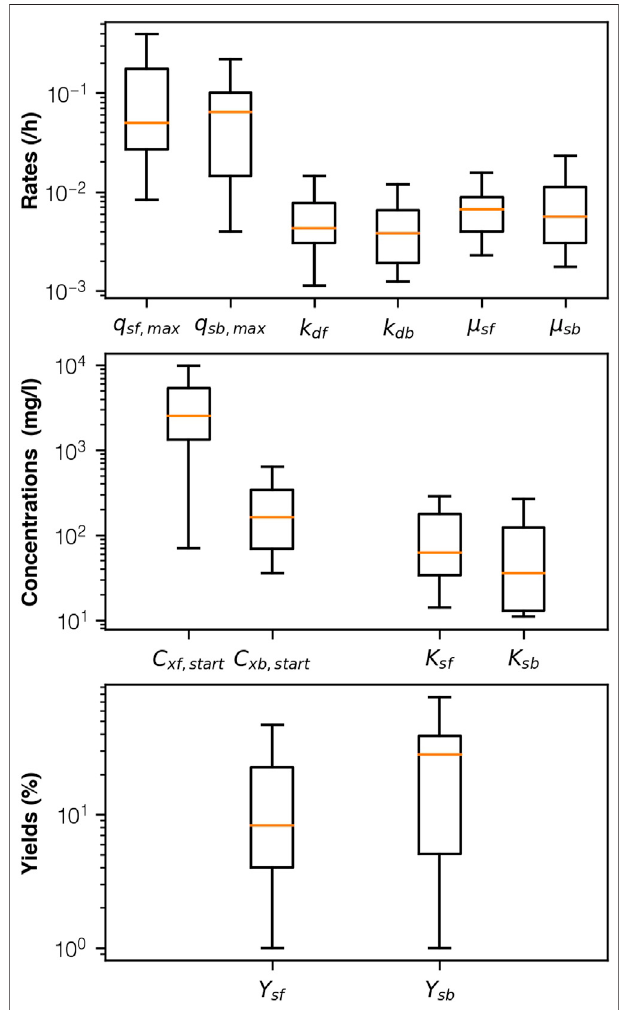
FIGURE 5 | Box-plot description for “ best fi t ” parameters following calibration. Largest difference between bio fi lm and bulk community observed for biomass concentration [1